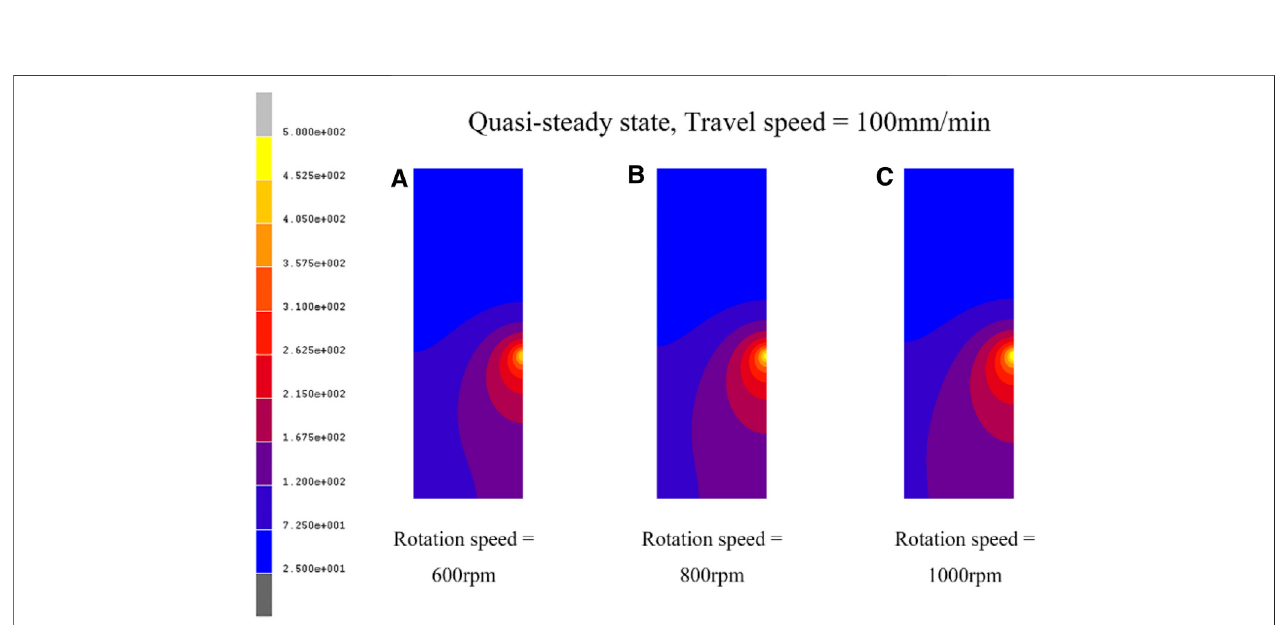
FIGURE 17 | Contours of temperature distribution on the upper surface under different rotation speeds: (A) 600 rpm, (B) 800 rpm, (C) 1000 rpm.